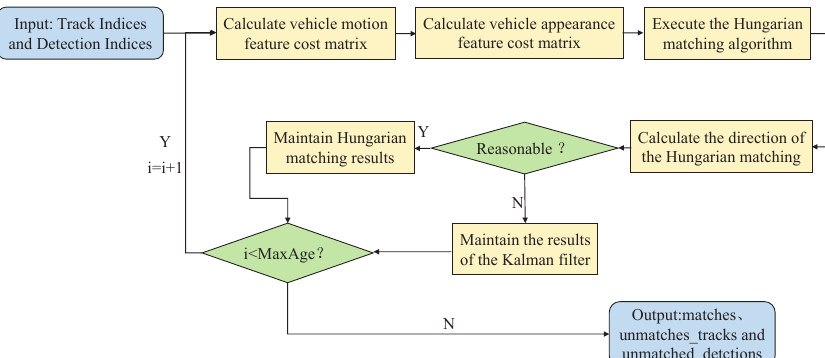
Figure 11. The cascade matching algorithm based on direction